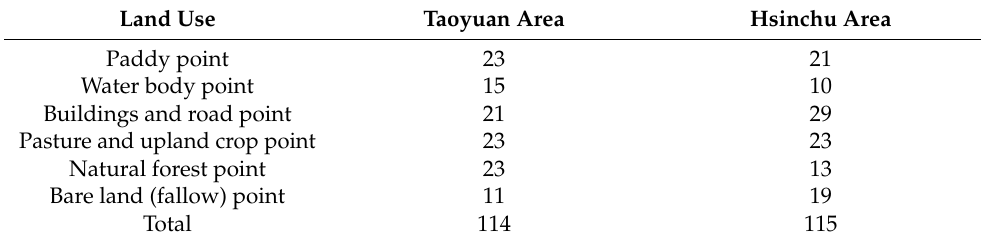
Table 1. Number of points of ground investigation and calibration in the research area. Land Use Taoyuan Area Hsinchu Area Paddy point Water body point Buildings and road point Pasture and upland crop point 23 23 Natural forest point 23 Bare land (fallow) point Total